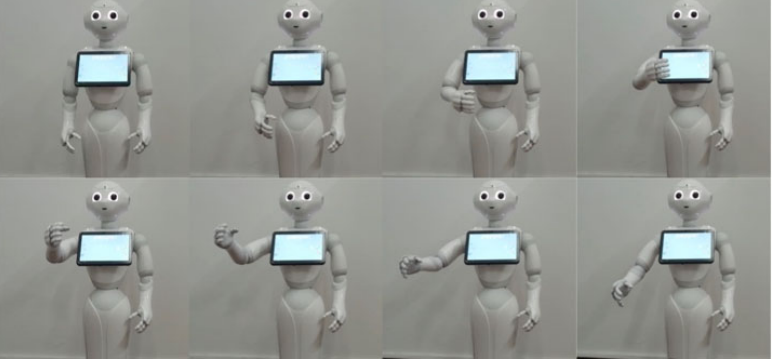
Figure 12. The anthropomorphic arm successfully generated the human ‐ like trajectory.